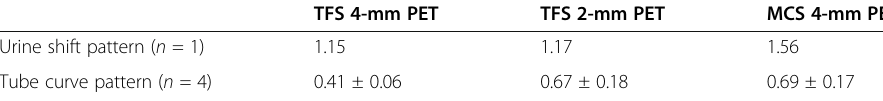
Table 2 Standard uptake values of 5 patients with halo